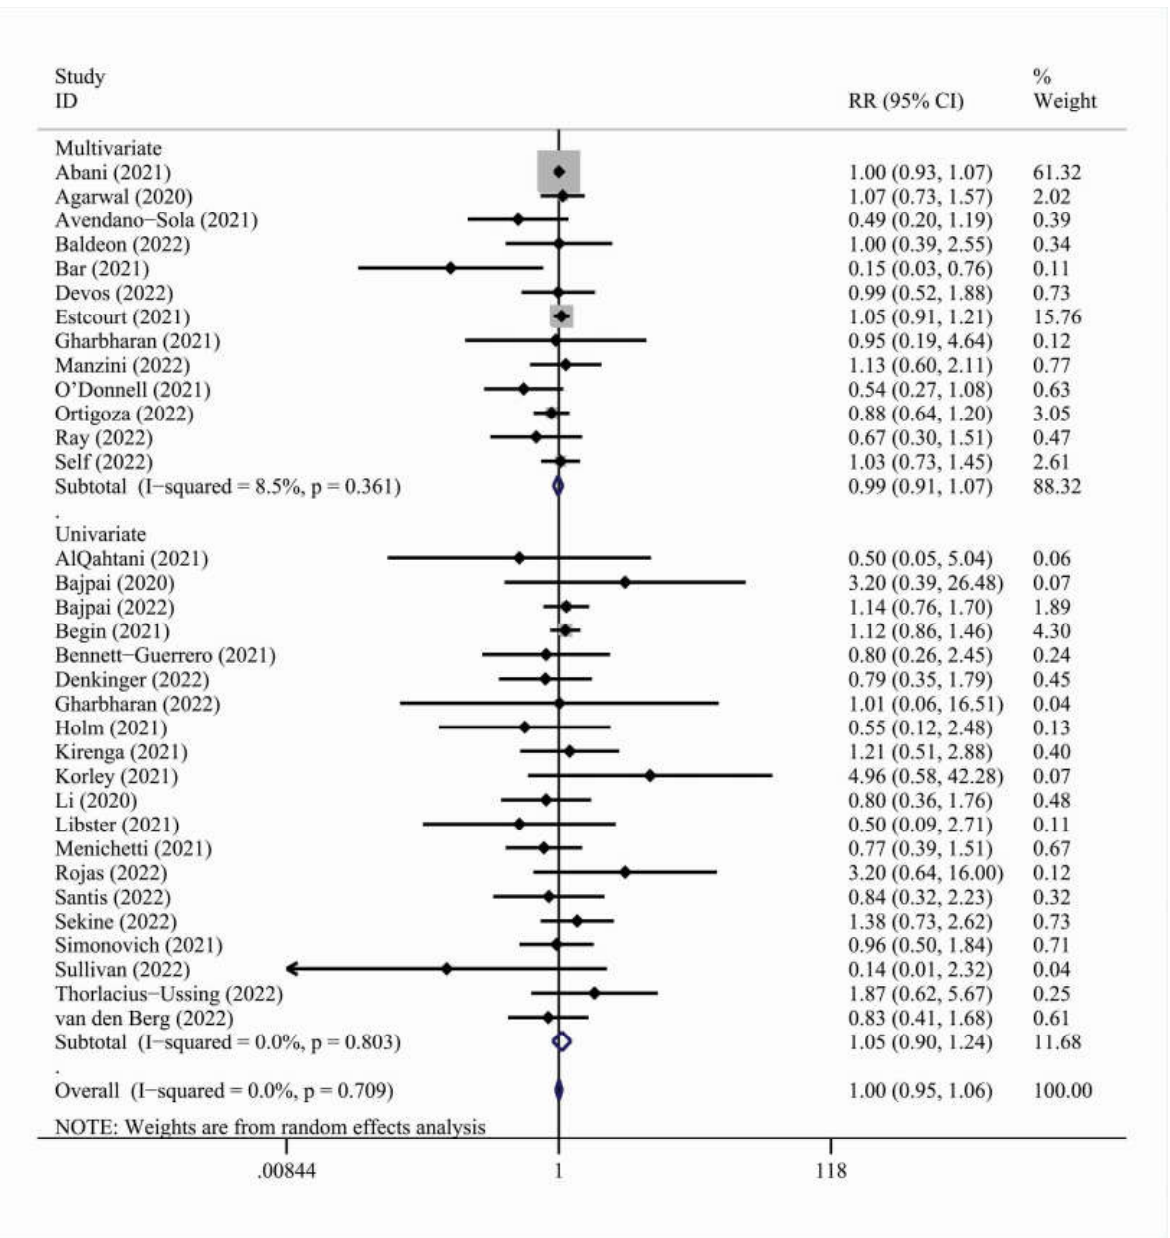
Figure 2. Forest plot describing the association between convalescent plasma treatment and 28-day mortality. Apart from the overall analysis, the subanalysis on adjustment type is presented. Table 3. Results of the meta-analyses examining the association between convalescent plasma ther- apy and mortality (28-day); subgroup analyses by adjustment, multicenter status, blinding status and geographic region are presented.